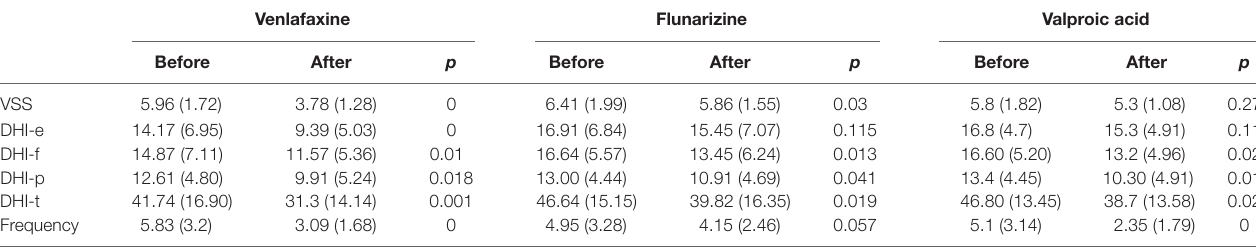
TaBlE 3 | Groups before and after treatment with regard to symptom (VSS), disability (DHI), and attack frequency. Venlafaxine Flunarizine Valproic acid Before after p Before after p Before after p